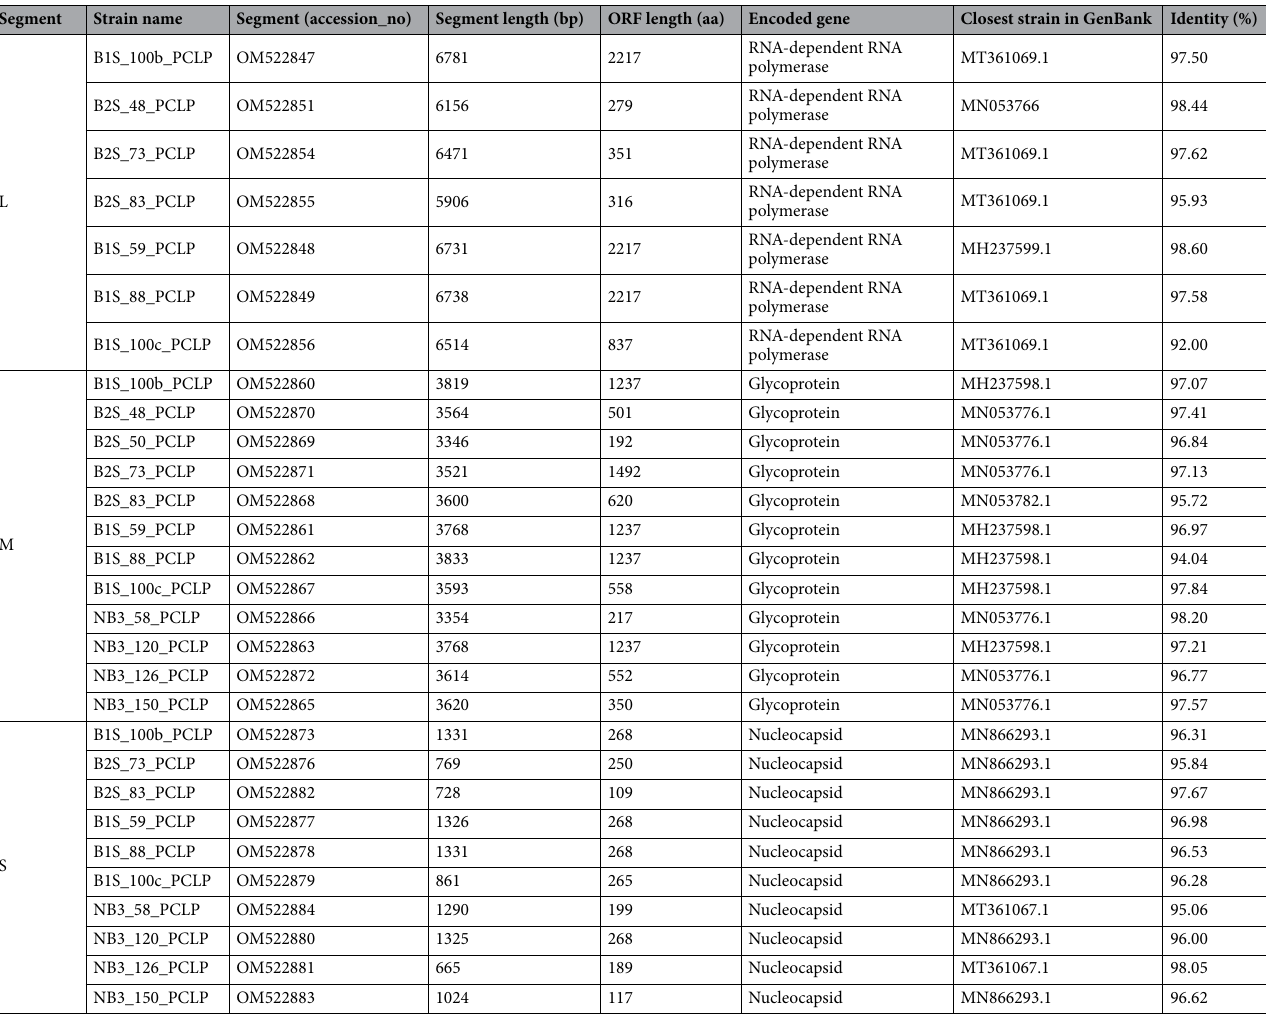
Table 3. Genome characterization of Phasi Charoen-like phasivirus genome described in this study.